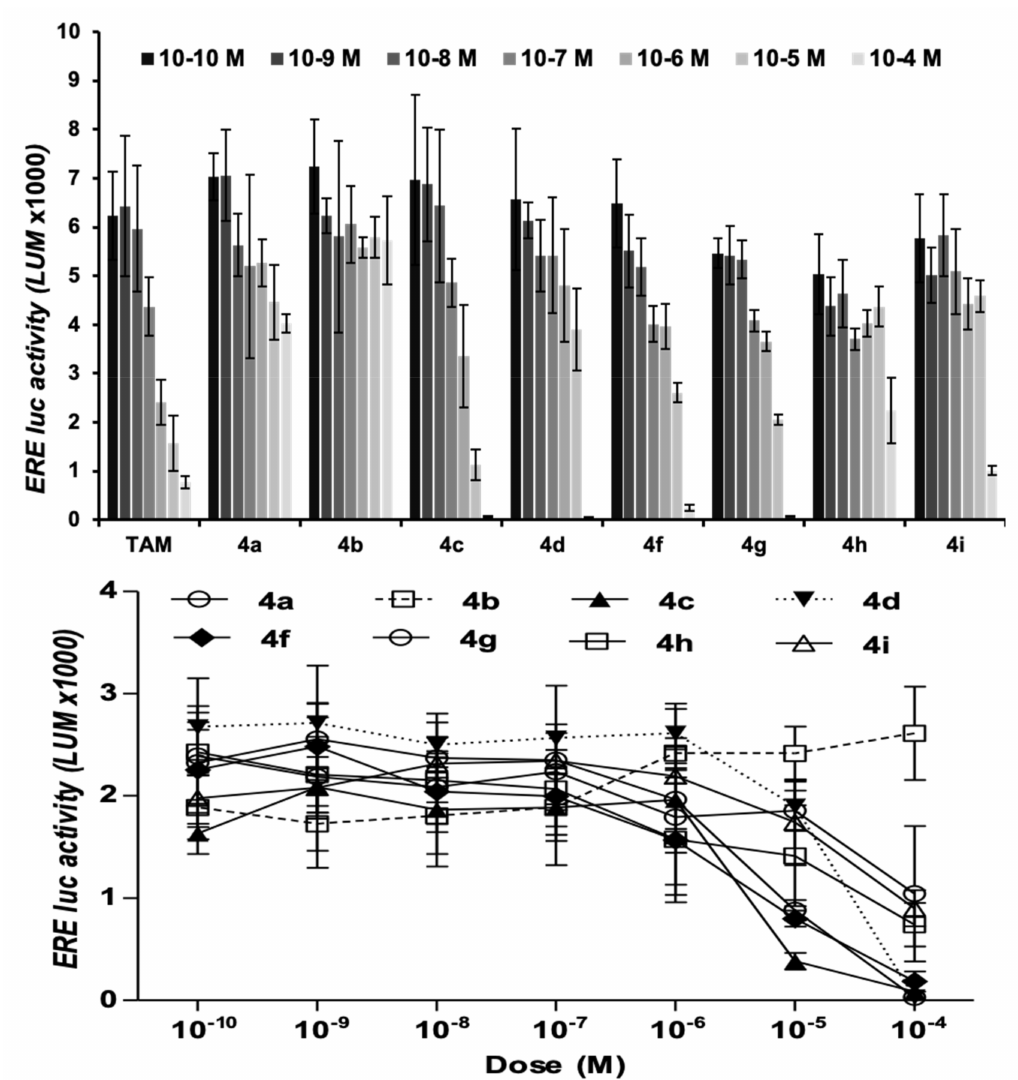
Figure 3. Inhibition of 17 β oestradiol (E2) stimulated oestrogen response element (ERE) transcrip Table 2. (lower panel). MCF7 cells were co-transfected with ERE-luc (firefly luciferase) and Renilla luciferase constructs as described in the Materials and Methods section. Cells were incubated with 17 β oestradiol (E2) (10 − 8 M) (Upper panel) and ATBA compounds (10 − 10 to 10 − 4 M) and without oestradiol (lower panel). Results are shown as mean (+SD for triplicate transfection). TAM: